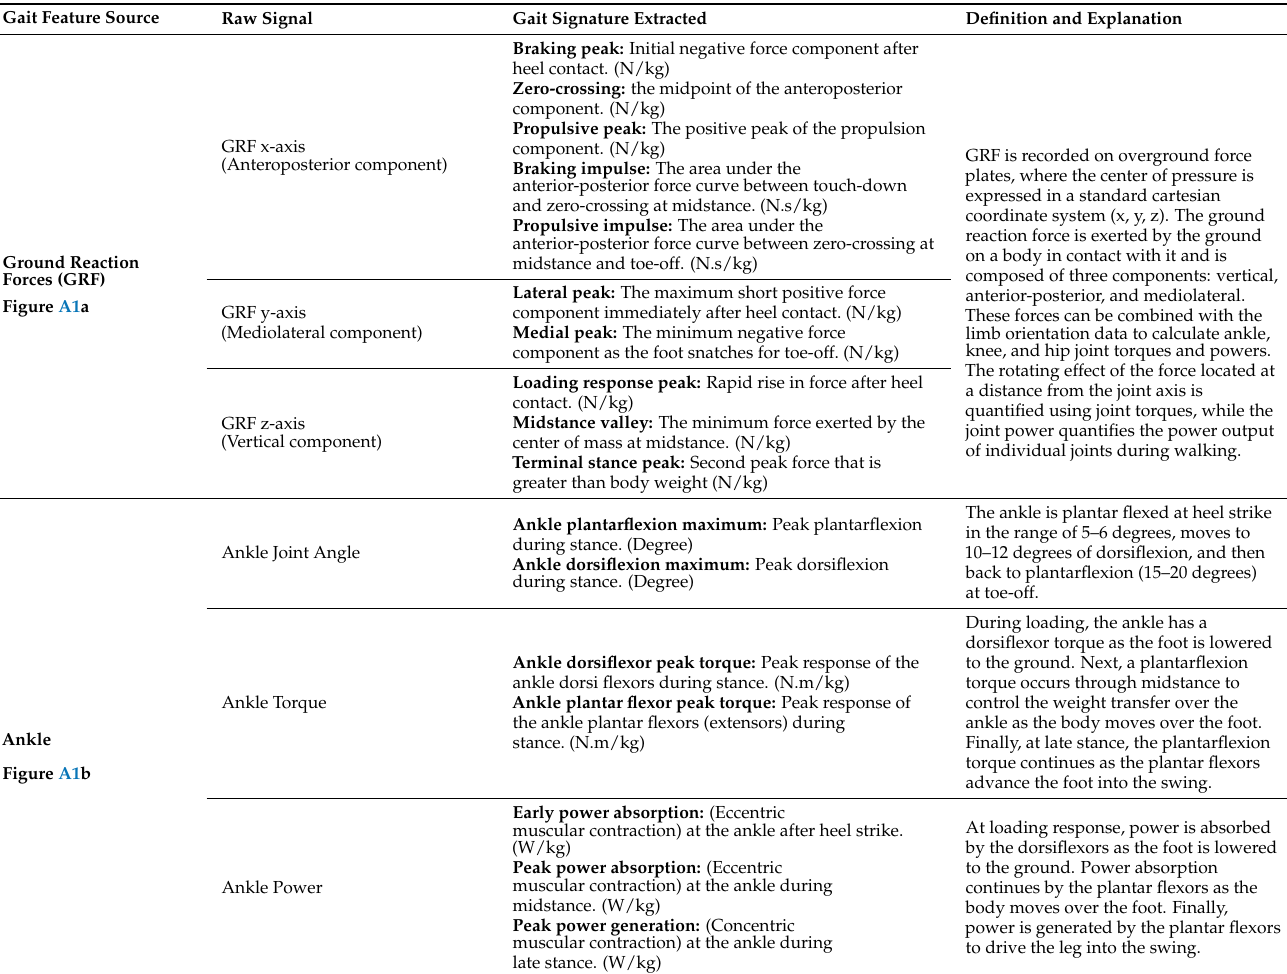
Table A1. Biomechanics Data and Gait Features Sources and Descriptions.